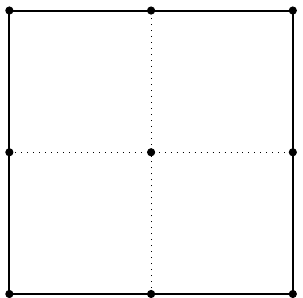
Figure 8 . Newton polygon for ( N; M ) = (2 ;